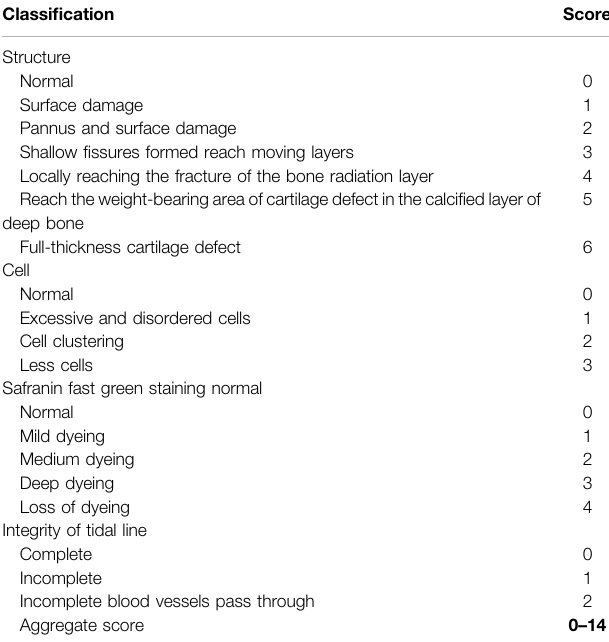
TABLE 1 | Mankin Score — scoring standard of articular pathology ( Supplementary Material ). Classi fi